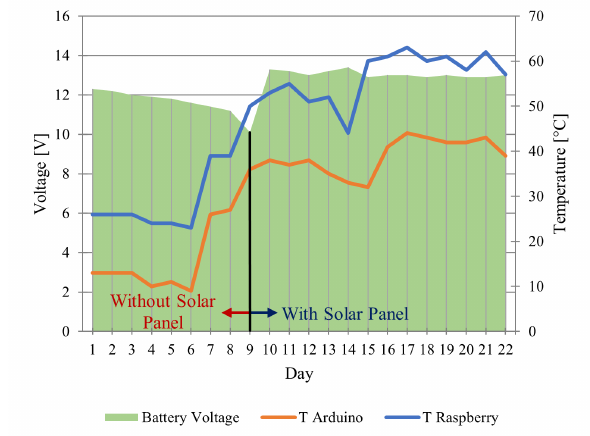
Figure 4. Battery voltage and temperature of boards with and without the solar panel during a period of tests. Starting from a fully charged condition, the system was kept without solar panel at around 2 °C for the first six days. After nine days, the battery was fully discharged and the system was reconnected to the panel and exposed to solar radiation.